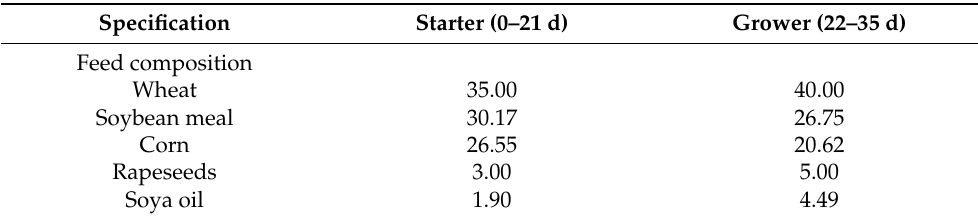
Table 1. Calculated composition and nutritional value of the basal starter and grower diets, % (as-fed